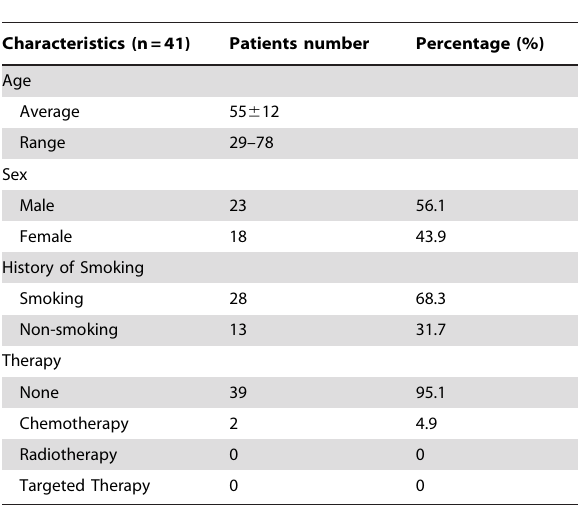
Table 1. Patients